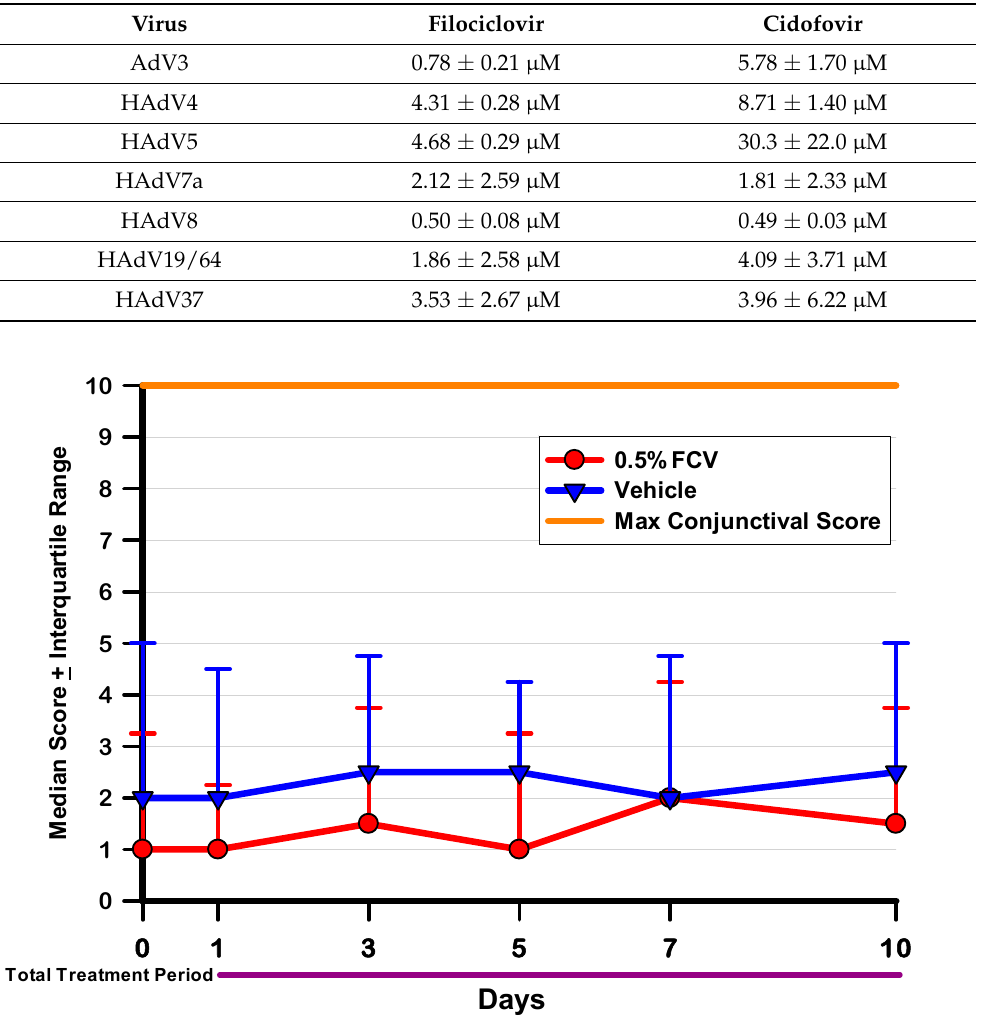
Figure 2. Median and interquartile ranges of the total conjunctival scores for 0.5% FCV and vehicle for each observation day in the ocular toxicity study. There were no significant differences between 0.5% FCV and the vehicle for any day ( p > 0.05, K–W).